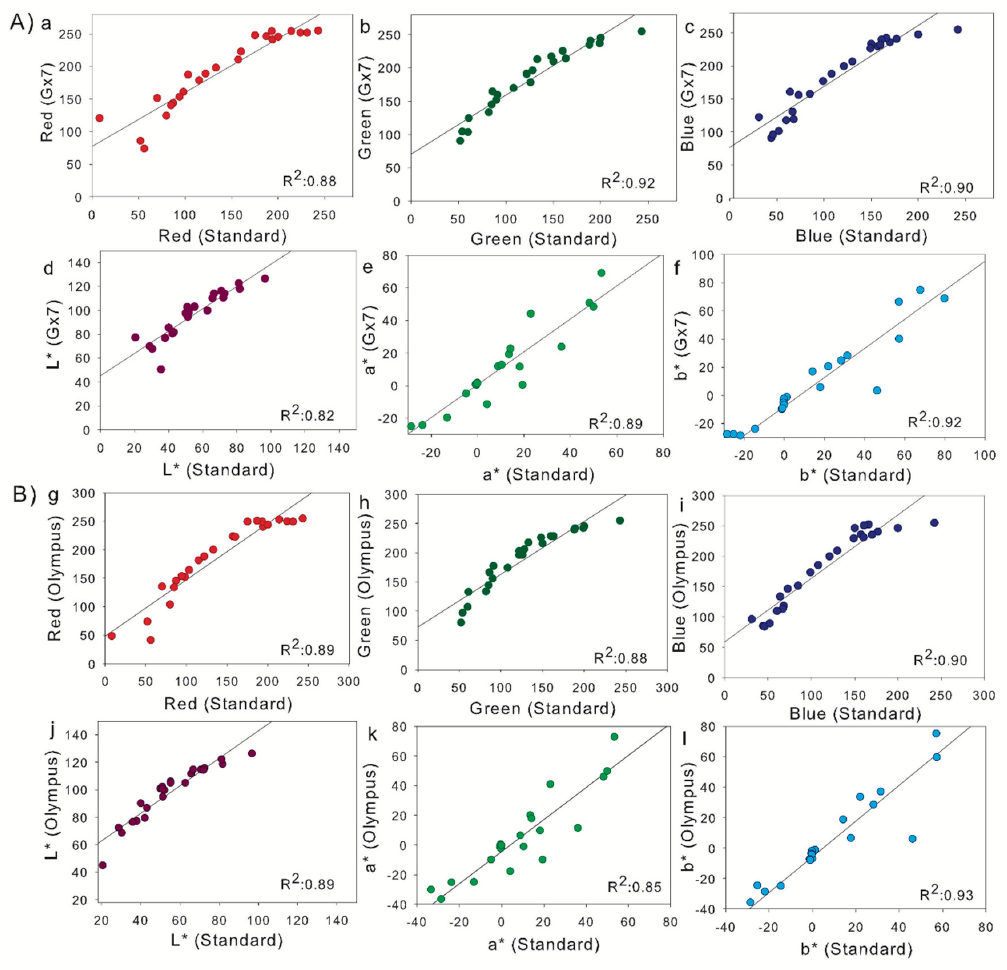
Figure 5. Color calibration through ColorChecker Passport. ( A ) The determination coefficients between the photo taken with Lumix GX7 camera for each channel red, green, and blue ( a – c ) and Commission Internationale de I´Edairage (CIE)Lab color space ( d – f ) (n = 24). ( B ) The determination coefficients between the photo taken with the Olympus OM-D camera for each channel red, green, and blue ( g – i ) and CIELab color space ( j – l ) (n = 24).